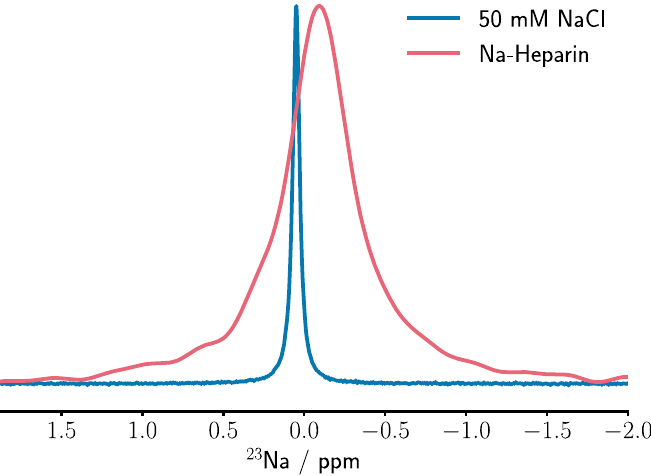
Figure 1. 1D 23 Na NMR spectrum of the sodium heparin sample (red), showing a significant signal broadening and a small displacement towards negative chemical shifts when compared to the reference NaCl sample (blue).